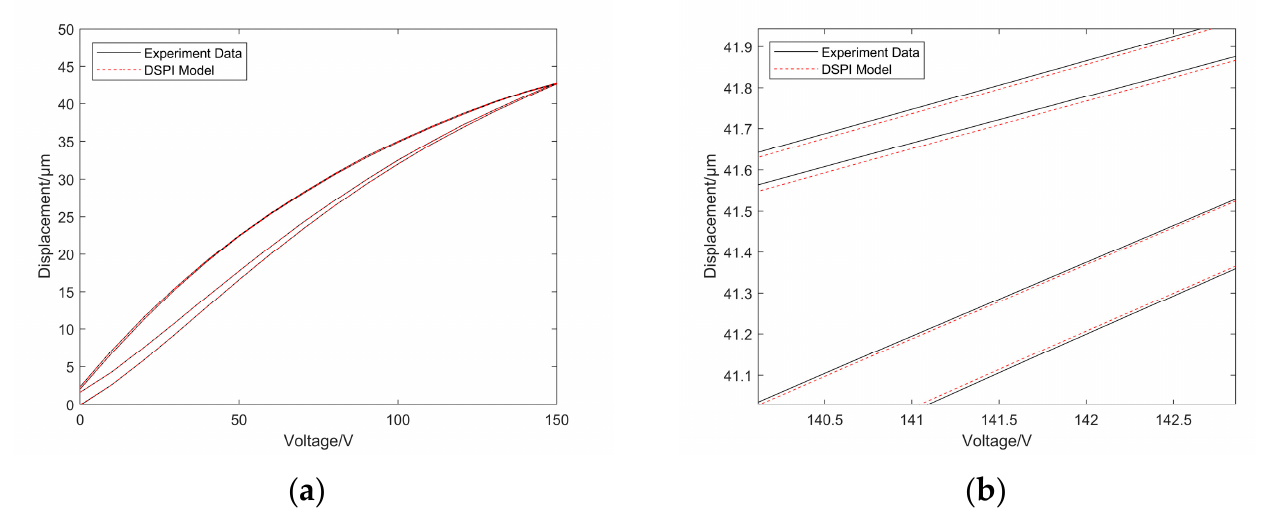
Figure 17. DSPI model: ( a ) modeling of the hysteresis characteristics after merging the first and new second cycle data; ( b ) local enlargement.